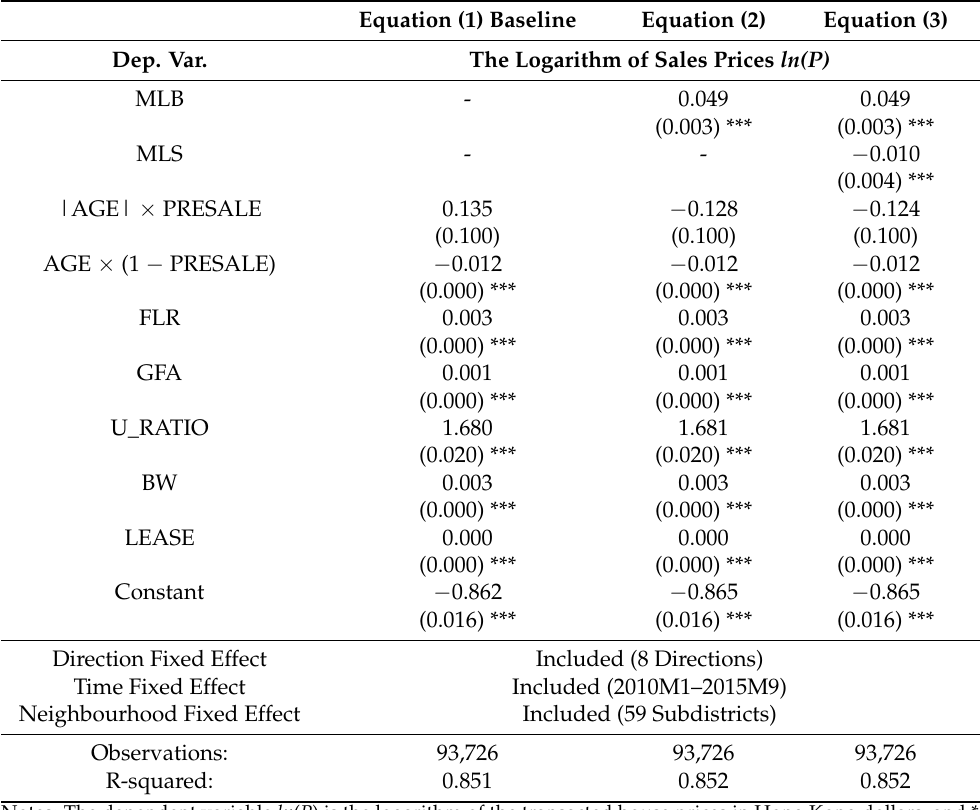
Table 3. The results of the hedonic price